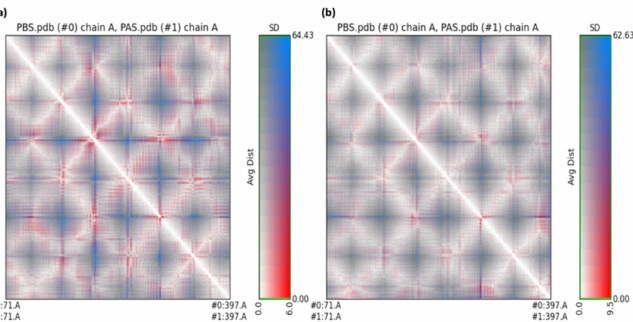
Figure 11. RR distance map: ( a ) unbounded dopamine receptor and dopamine receptor after simula- tion for HPLD and ( b ) unbounded dopamine receptor and dopamine receptor after simulation for CTtD, [PAS (#1) value = protein after simulation, SD = Standard deviation].